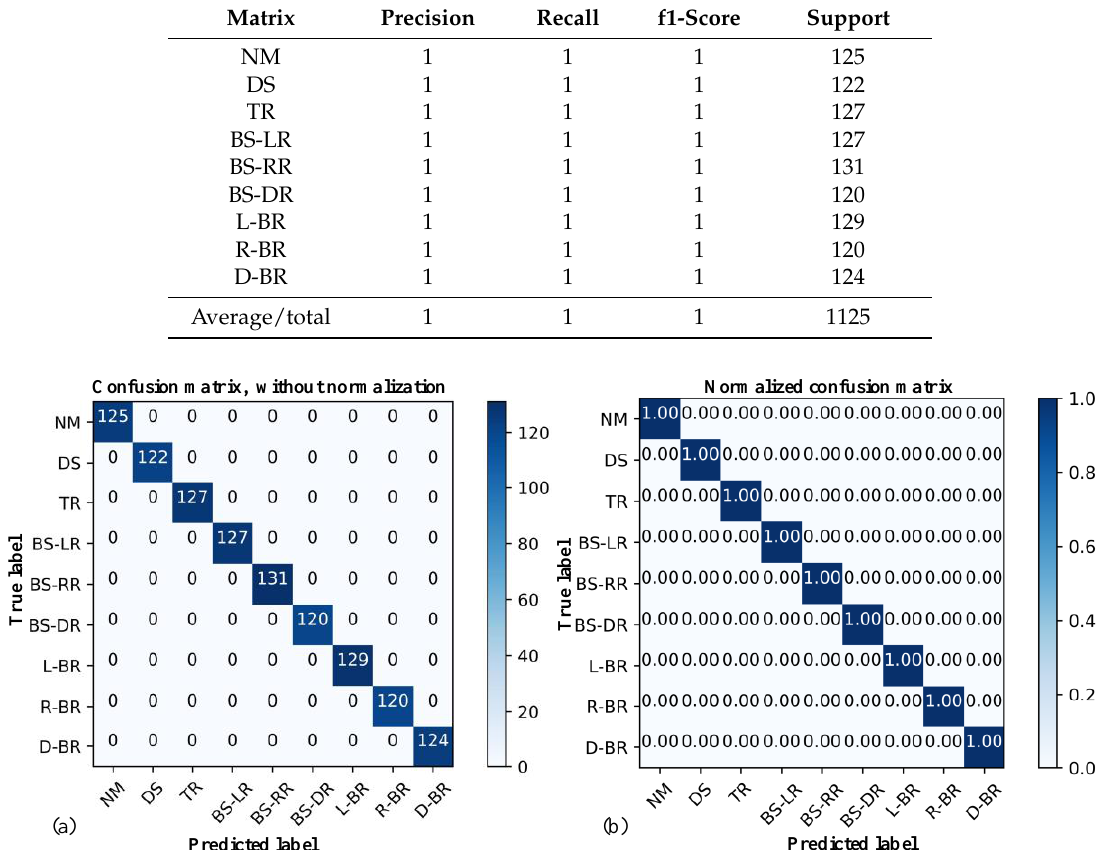
Figure 11. CNN confusion matrices. ( a ) Without normalization; ( b ) normalized.